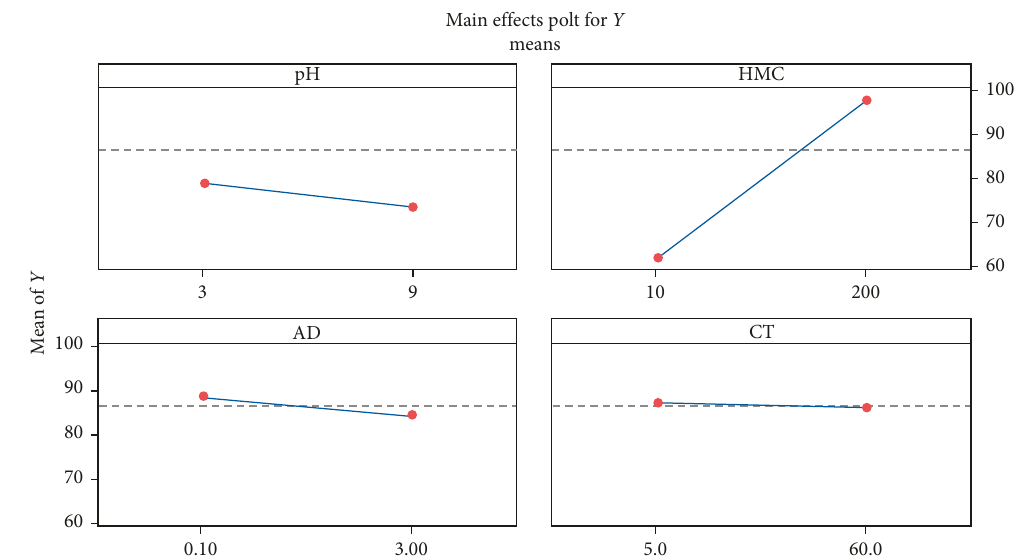
Figure 3: Main effects plots acquired subsequent to response transformation. A gray background represents a term not in the model. Cube plot (fitted means) for Y